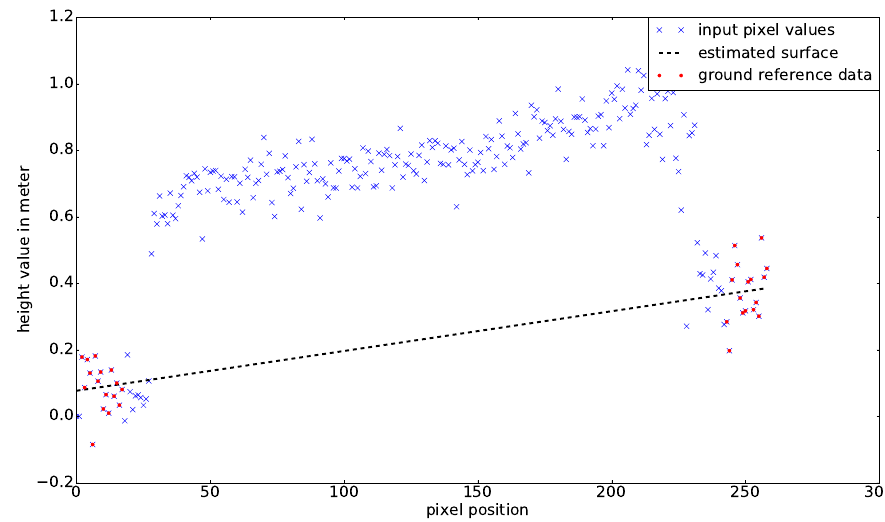
Figure 7. 2D cross-section of ground-level approximation using estimated soil